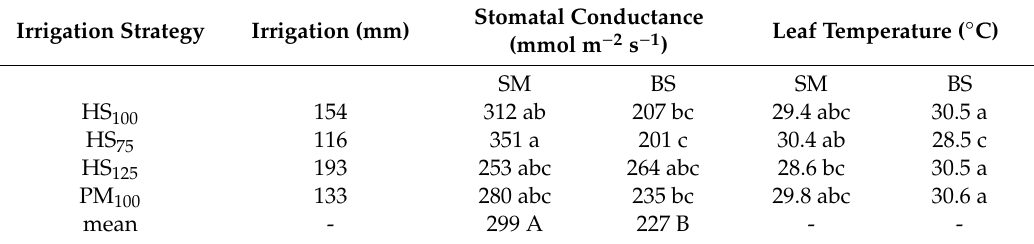
Table 5. Experiment 2: E ff ect of the interaction between irrigation strategy and soil mulching on the physiological parameters of lettuce. Di ff erent letters indicate significant di ff erences in the Tukey HSD test ( p ≤ 0.05). Lower case letters indicate di ff erences between treatments; capital letters indicate di ff erences between the means of the soil mulching factor. Data are the means of three replicates. HS 75 = recovery of 75% ET c calculated by the Hargraves–Samani equation; HS 100 = recovery of 100% ET c calculated by the Hargraves–Samani equation; HS 125 = recovery of 125% ET c calculated by the Hargraves–Samani equation; PM 100 = recovery 100% of ET c calculated by the Penman–Monteith equation. SM = Straw mulching; BS = Bare soil.